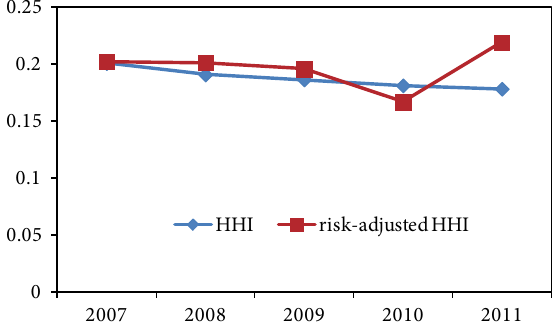
Fig. 1. Tendency of hhi and risk-adjusted hhi in